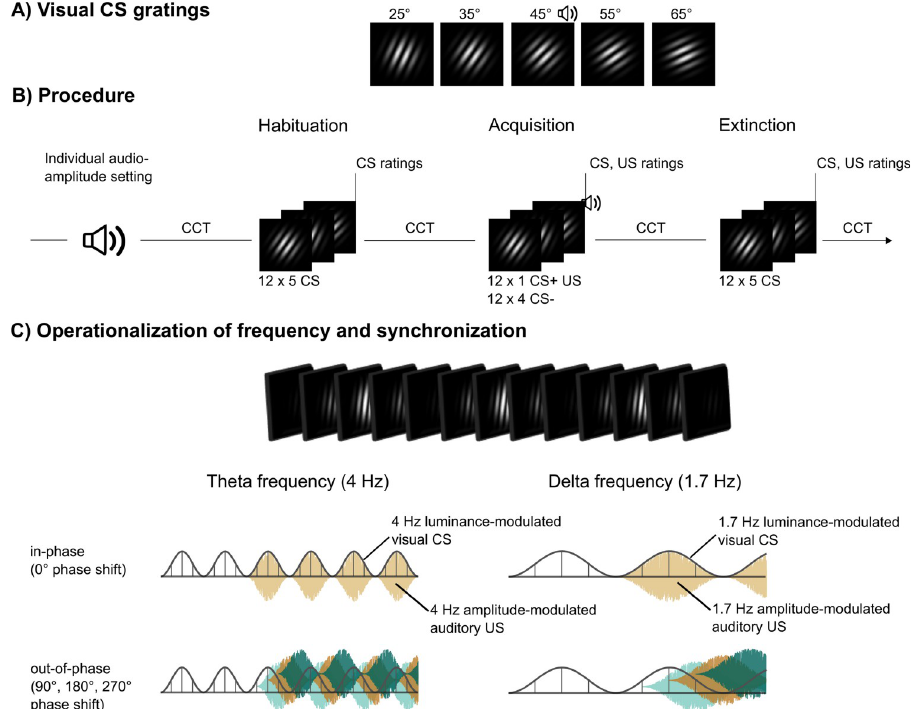
Fig 1. Experimental design. Gabor gratings, conditioning procedure, and the operationalization of in-phase versus the out-of-phase in a theta- (4 Hz) or delta- (1.7 Hz) frequency band. (A) For CS, we used Gabor gratings that only differed in orientation by 10˚. The 45˚ orientation served as CS+ and was therefore paired with the US during acquisition. The other four orientations (25˚, 35˚, 55˚, and 65˚) were used as CS- gratings, hence never paired with the US. (B) The fear conditioning paradigm comprised the learning phases habituation, acquisition, and extinction. Prior to habituation, participants conducted the individual audio-volume setting (titration) to select an US intensity that is extremely unpleasant but not painful. Within a learning phase, each CS orientation was presented 12 times. Only during acquisition, the US with the individually set intensity was presented together with the CS+ (45˚) orientation. After each learning phase, valence and arousal ratings were conducted for the CS and–after acquisition–the aversive US. US-expectancies were rated after acquisition and extinction. At four time points (before and after habituation, after acquisition, and after extinction) participants conducted the unheralded compliance control task (CCT). (C) Operationalization of the in-phase (0˚ phase shift) versus out-of-phase (90˚, 180˚, 270˚ phase shift) synchronization in a theta- (4 Hz) or delta- (1.7 Hz) frequency band. Each visual CS and auditory US was sinusoidally luminance or amplitude modulated, respectively, at either 4 Hz (theta) or 1.7 Hz (delta). The left column shows phase shifts for the theta band: in-phase, i.e., 0˚ (beige) shift at the top and out-of-phase, i.e., 90˚ (light green), 180˚ (brown), 270˚ (dark green) shift at the bottom. The right column depicts the same phase-shifts for delta.